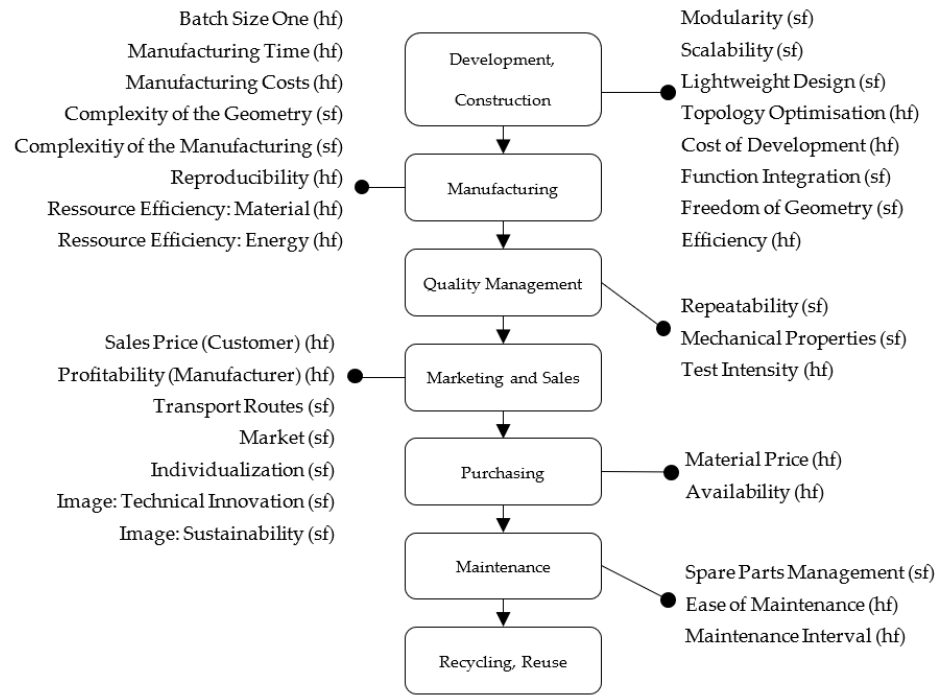
Figure 1. Product life (PL) including 7 categories and 31 criteria categorised as hard factors (hf) and soft factors (sf).